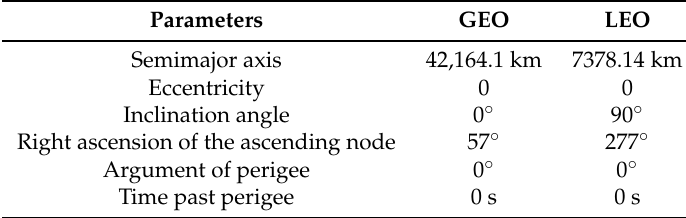
Table 1. Orbital parameters of the GEO and LEO satellites.